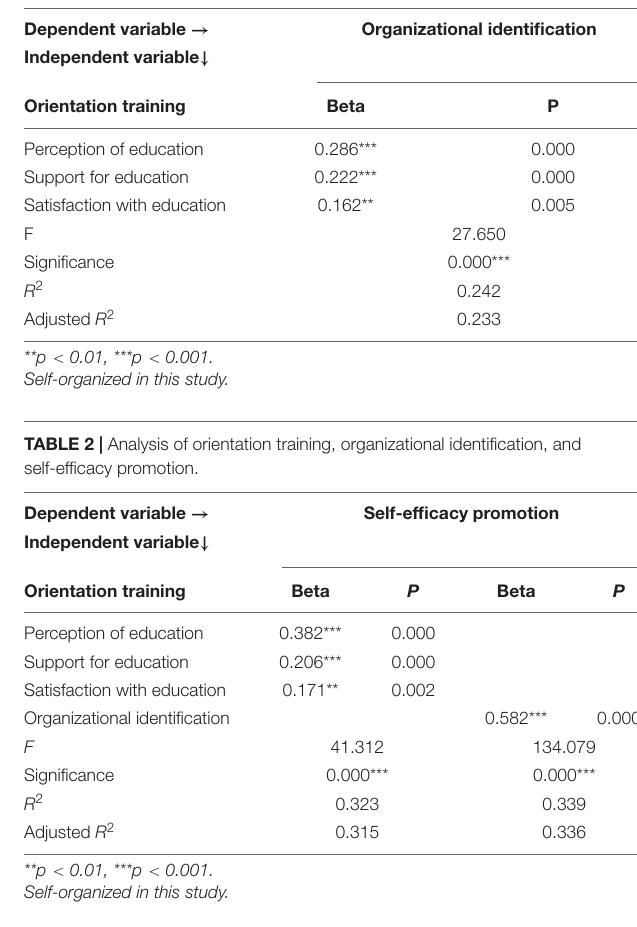
TABLE 1 | Analysis of the relationship between orientation training and organizational identification.